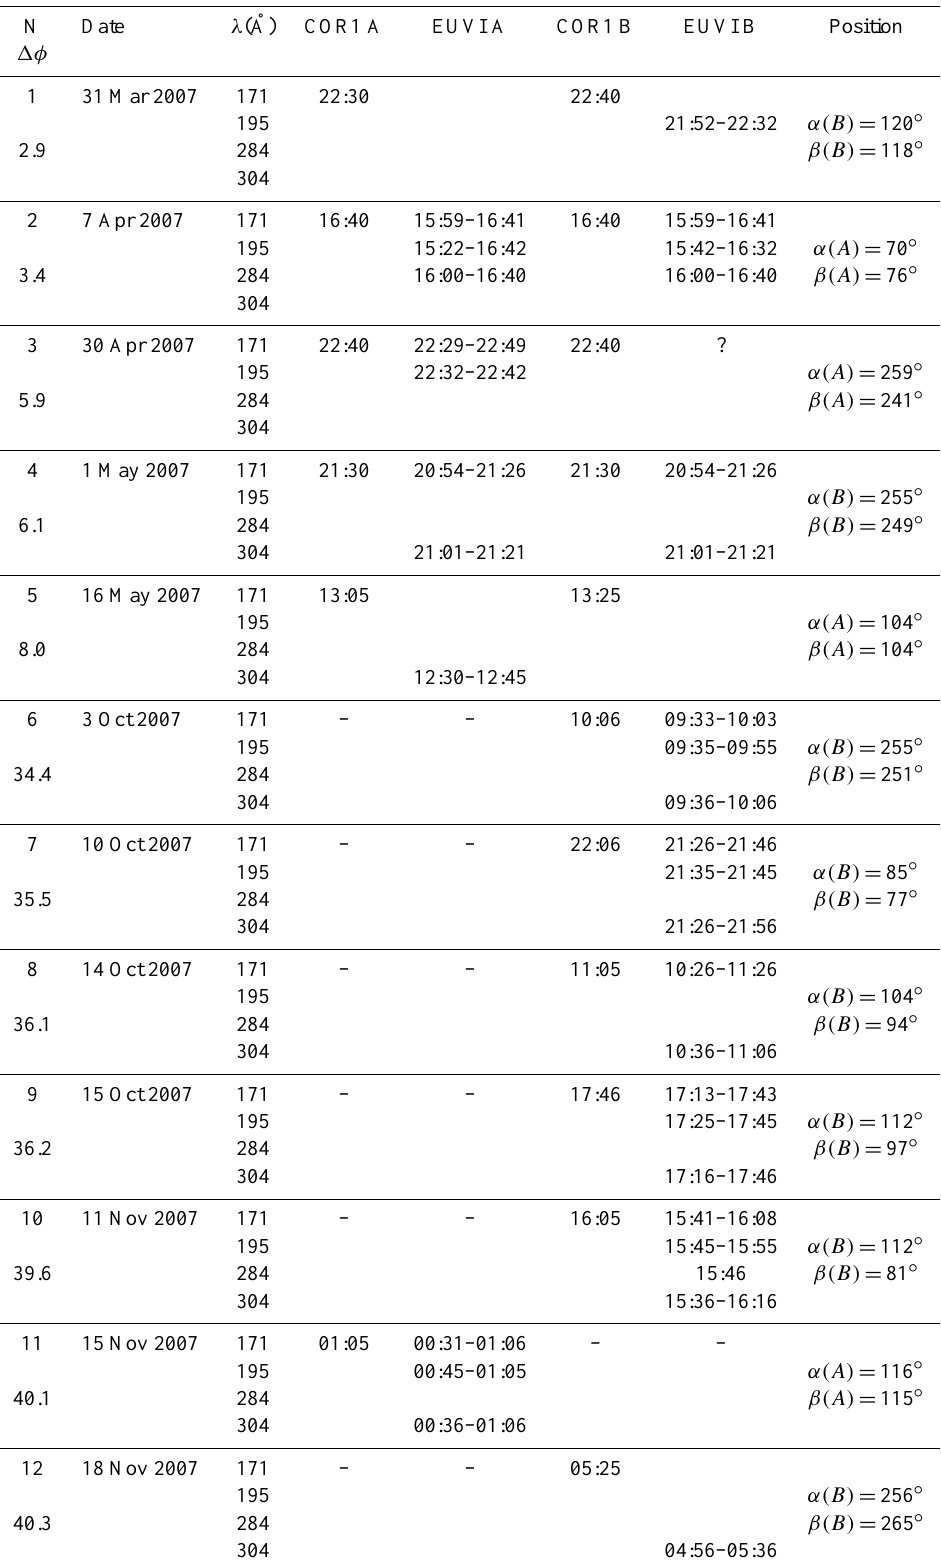
Table 1. List of equatorial coronal jet events identified from March to December 2007 from the STEREO EUVI and COR 1